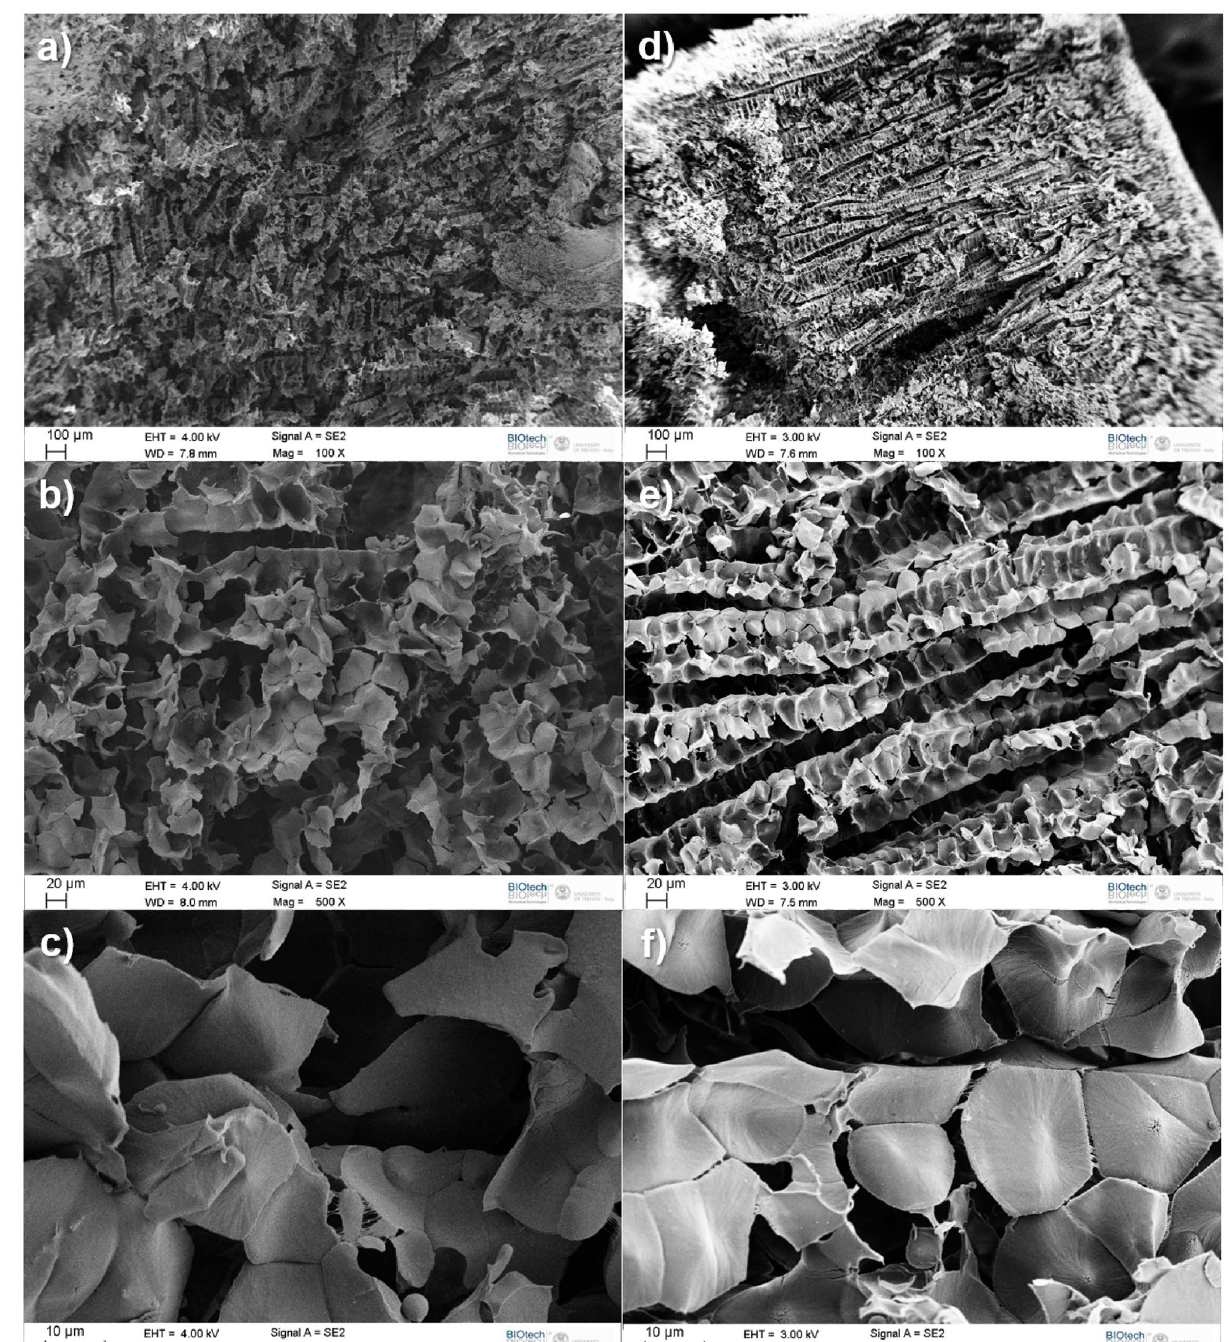
Figure 1. Scanning electron microscopy (SEM) images of the polypropylene foam structures obtained from the plastic produced with 47.5% weight ratio of camphene and camphor and 5% weight ratio of polypropylene ( a , b , c ) with the foam made using the plastic containing 45% weight ratio of camphene and camphor and 10% weight ratio of polypropylene ( d , e , f ). The magnifications were 100X ( a , d ), 500X ( b , e ) and 3000X ( c , f foam sample. Within four minutes the foam sample was able to almost completely absorb all of the oil from the surface and can be removed along with it. Furthermore, it is visible in Fig. 7f that the foam is not fully saturated. Porosity describes the fraction of void space in the material. It is a parameter that characterizes porous materials like foams 41 . It is defined as: